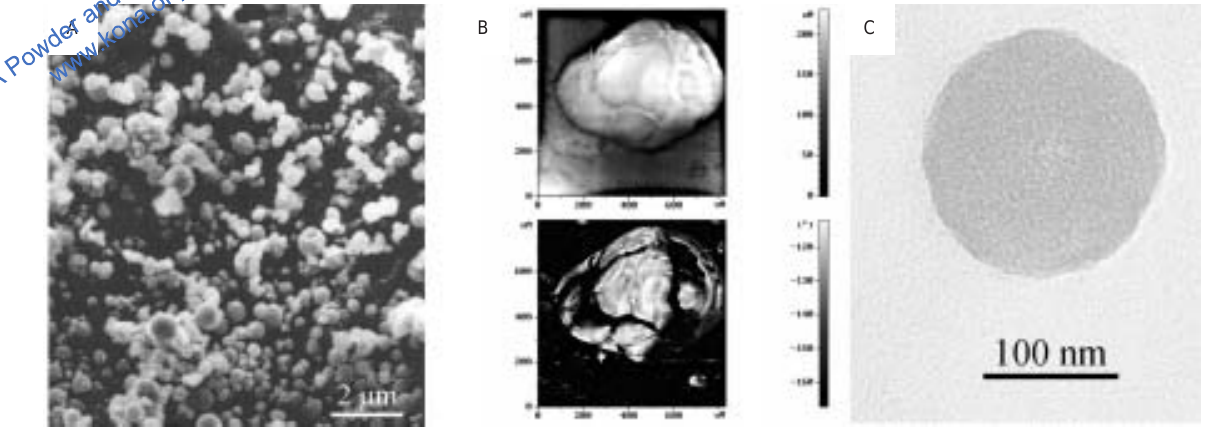
Fig. 2 Microphotographs of polytetrafluoroethylene nanogranules. (A,B,C, (cid:1) SEM, AFM, TEM images,